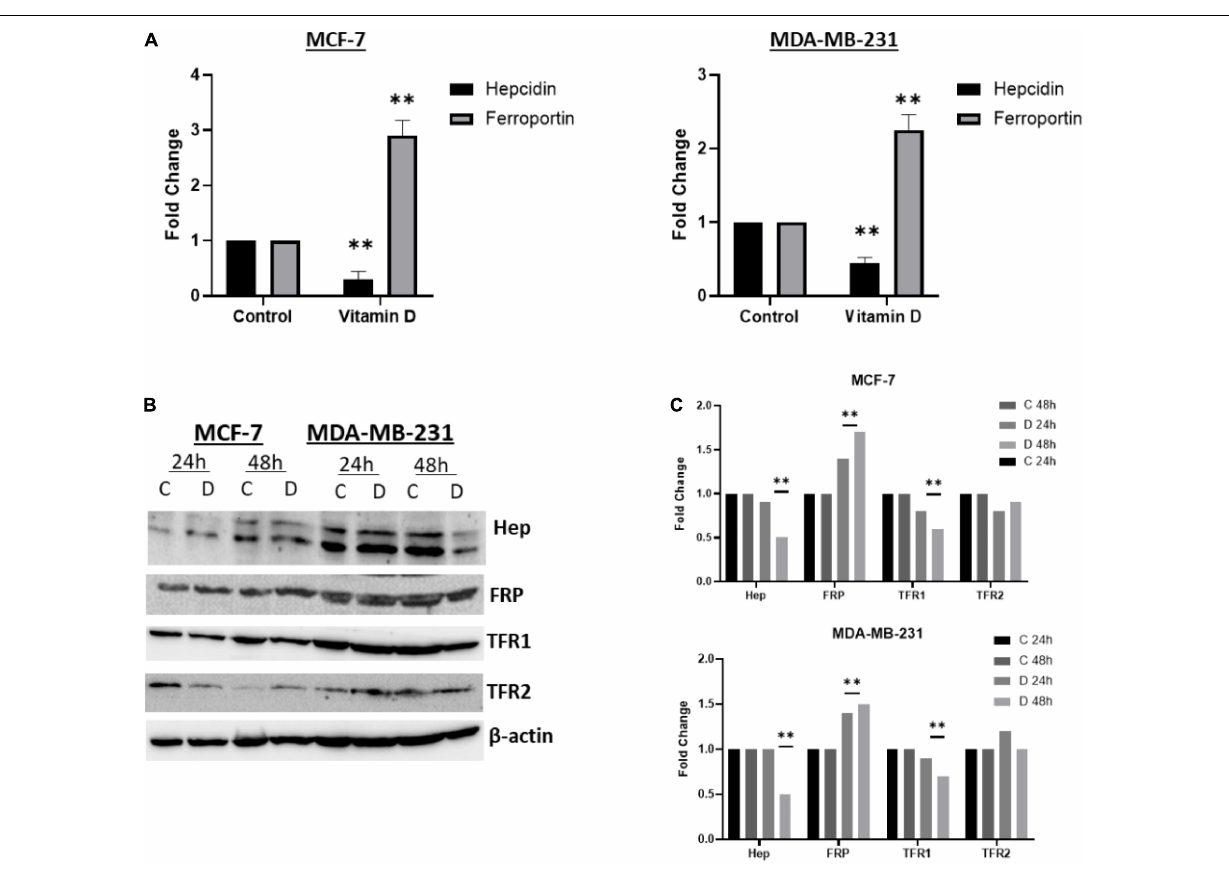
FIGURE 3 | Vitamin D disrupts cellular iron metabolism in BRCA cells. The status of hepcidin, FPN, TfR1, and TfR2 in vitamin D treated MCF-7 and MDA-MB-231 cells. (A) Gene expression was analyzed in from MCF-7 and MDA-MB-231 cells treated with vitamin D 10 µ M and cultured for 6 h. (B) Cell lysates were prepared from MCF-7 and MDA-MB-231 cells treated with vitamin D 10 µ M and cultured for 24 and 48 h. Shown data are representative of three separate experiments. (C) Quantitative analysis of relative protein band density after normalization to β -actin and compared to the control. **Represents statistically significant change ( P <